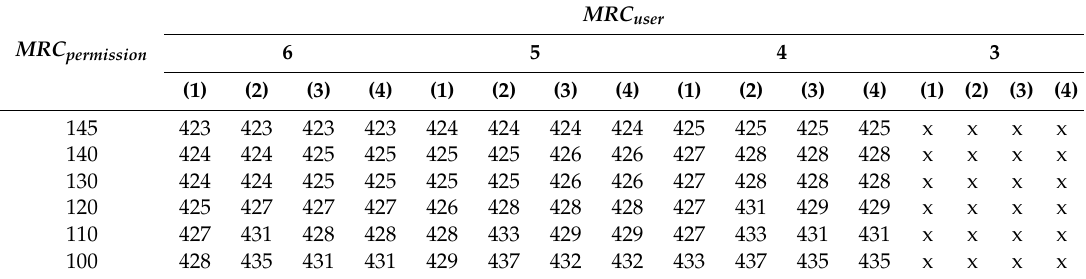
Table 19. The number of optimized roles in the America-large dataset.